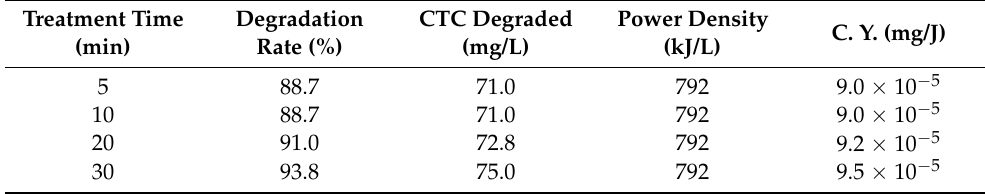
Table 3. C.Y. for different treatment times using HC combined with H 2 O 2 . Treatment Time Degradation CTC (min) Rate (%)